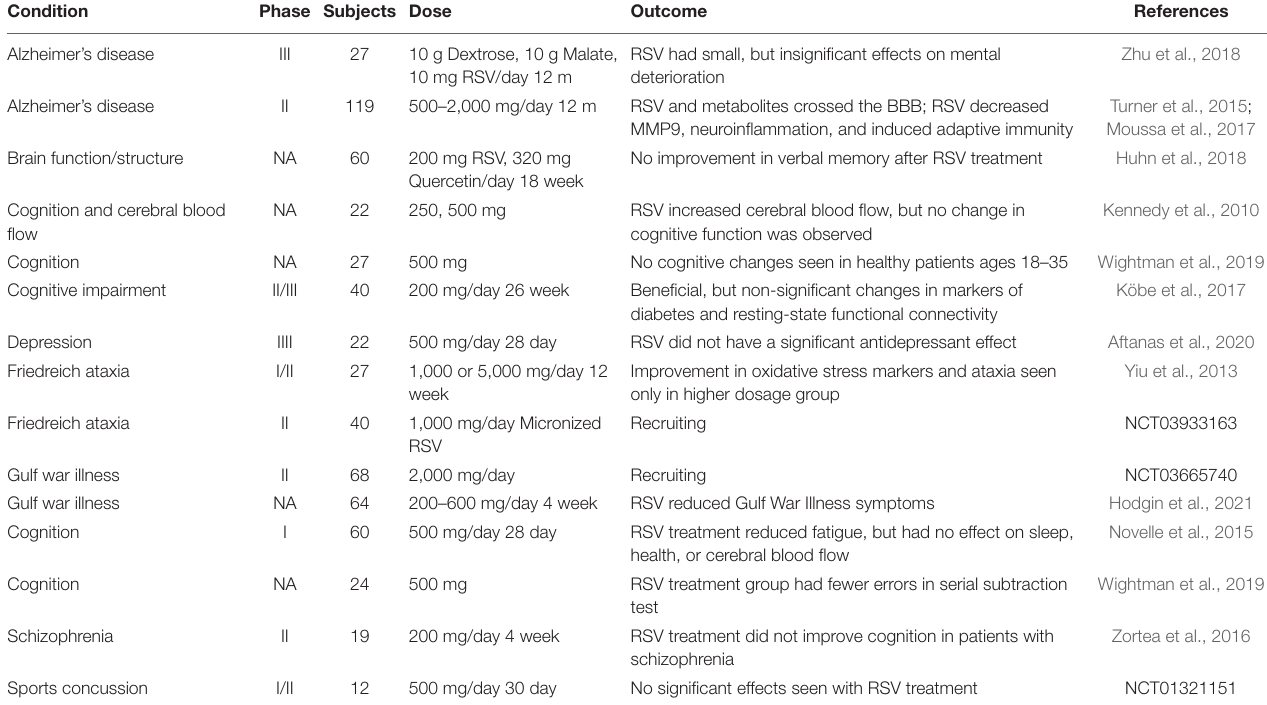
TABLE 4 | Clinical trials of resveratrol for cognition and neurological disorders.